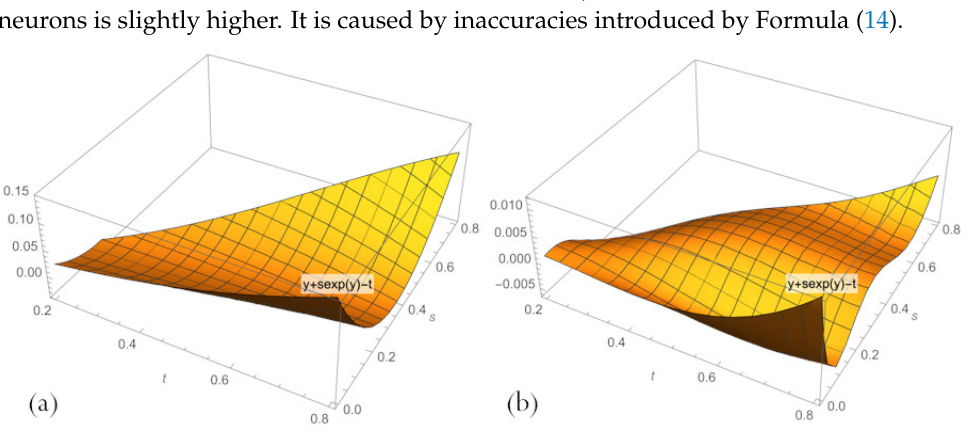
Figure 2. Errors in PBA solutions (17) to Equation (16), across domain 0 < s < t < 1, for n = 3 ( a ) and n = 10 ( b ).